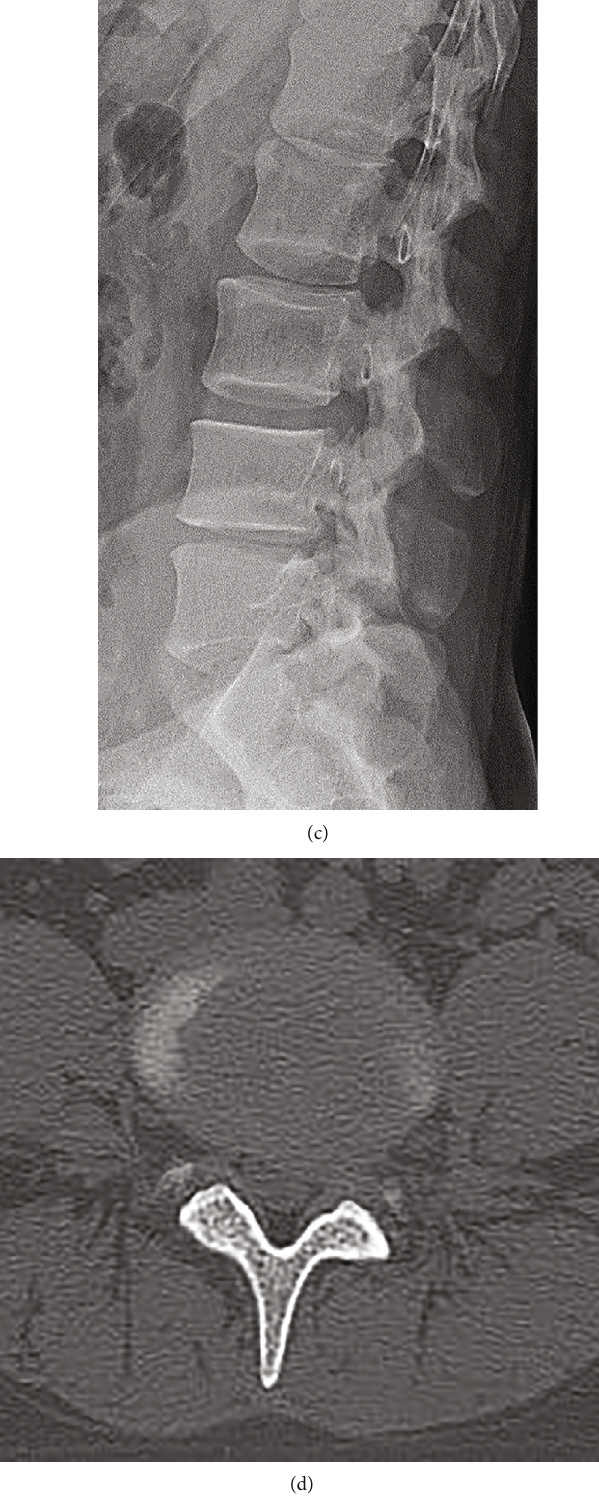
Figure 2: Spinal imaging before intradiscal condoliase injection. A (a) sagittal section and (b) horizontal section of the L4/5 on T2-weighted magnetic resonance imaging showed intracanal, left-sided transligamentous disc herniation with high-signal intensity. (a) The degree of a ff ected disc degeneration was grade III according to the P fi rrmann classi fi cation [9]. (c) Standing radiography revealed that the L4/5 disc height was slightly diminished as compared to the other discs. (d) Computed tomography showed no bony stenosis at